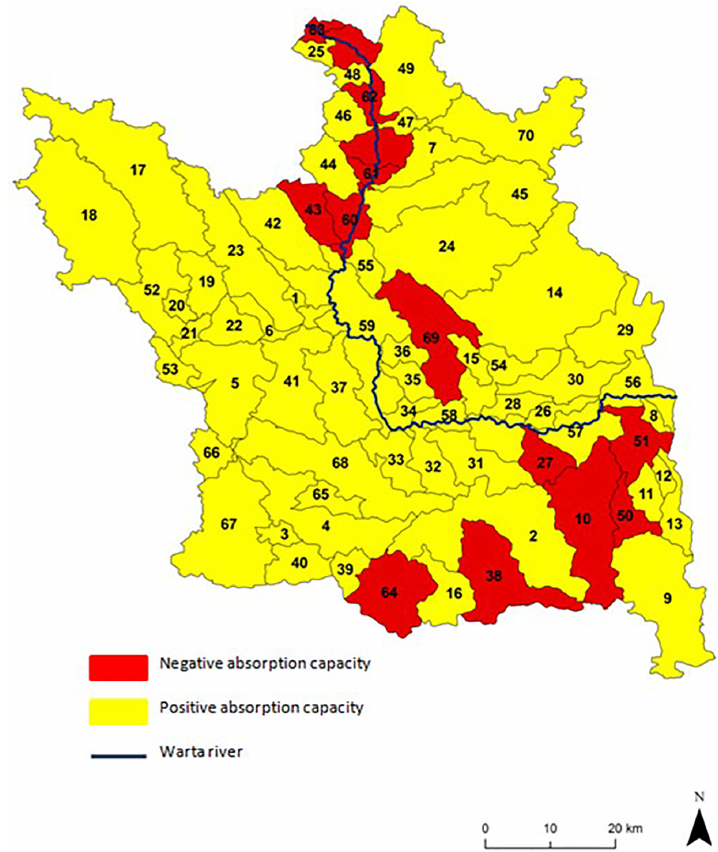
Figure 9. Actual absorption capacity for each water body of the Middle Warta for total phosphorous based on characteristic flow